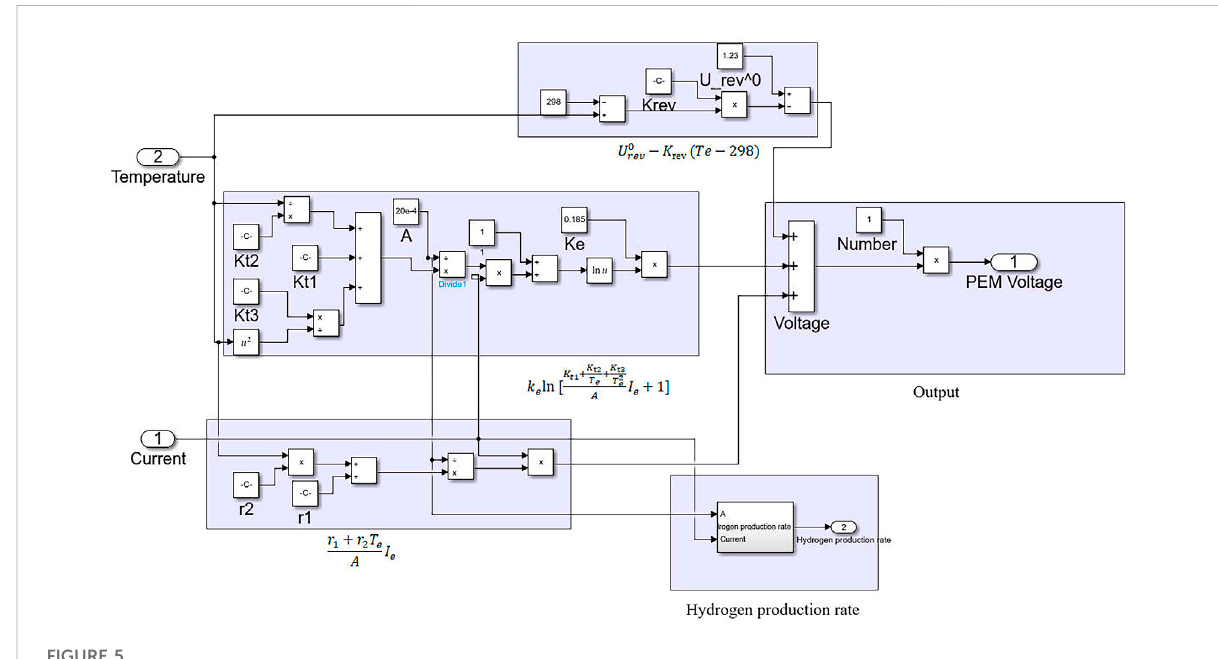
FIGURE 5 Electrolytic water to hydrogen model.